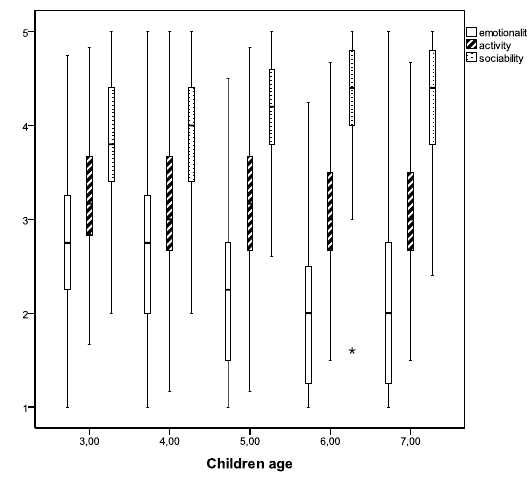
Figure 2 . Boxplot of EAS-dimensions according to children’s age (3, 4, 5, 6 and 7